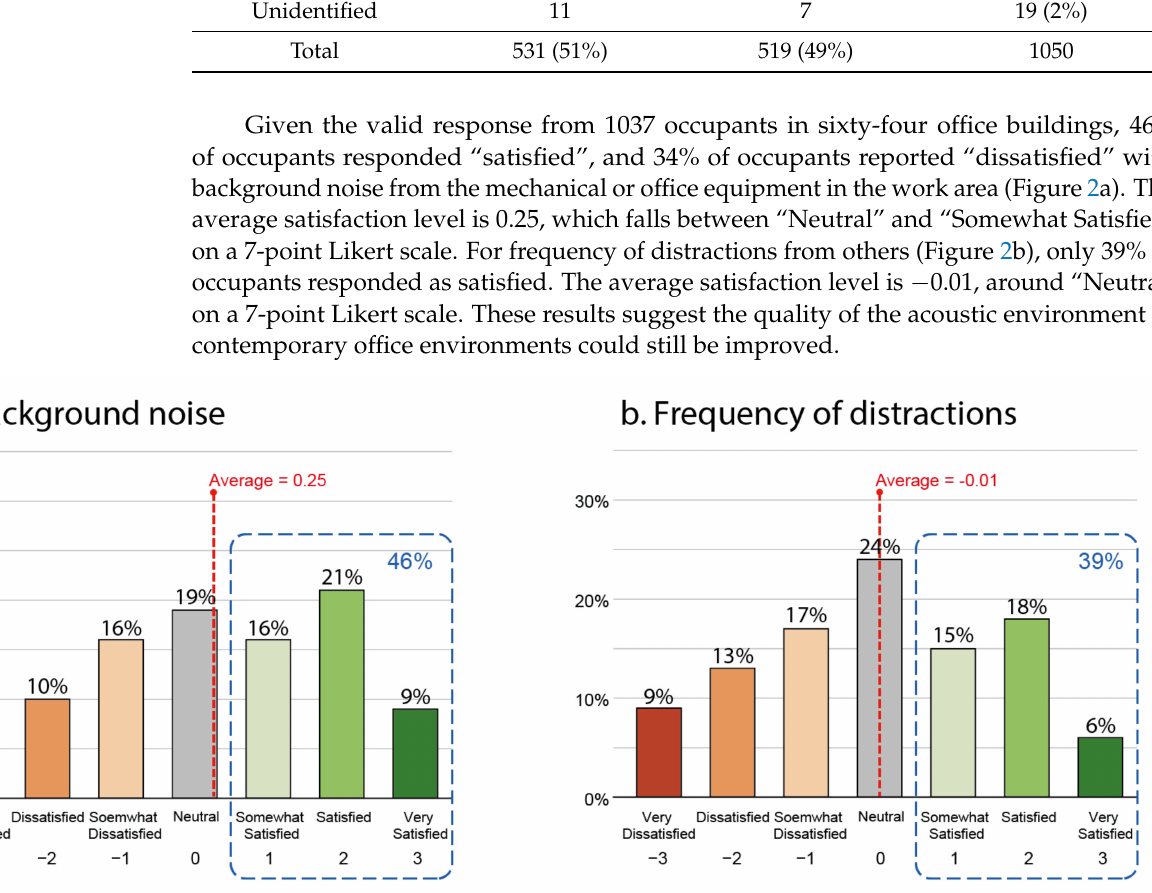
Figure 2. Acoustic satisfaction survey results: ( a ) Background noise from mechanical or office equipment you hear in your work area; ( b ) frequency of distractions from other people, from 1037 workstations in 64